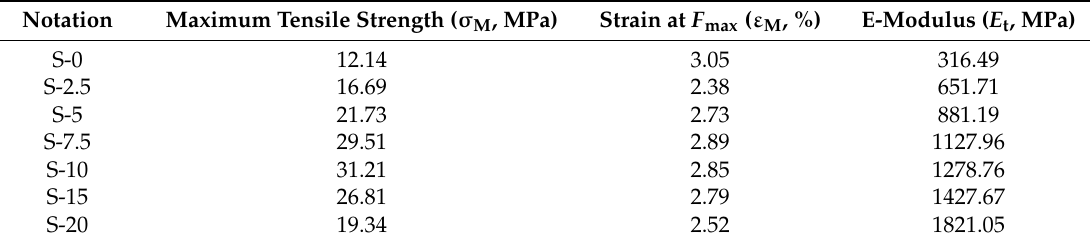
Table 3. Mechanical properties of free films.